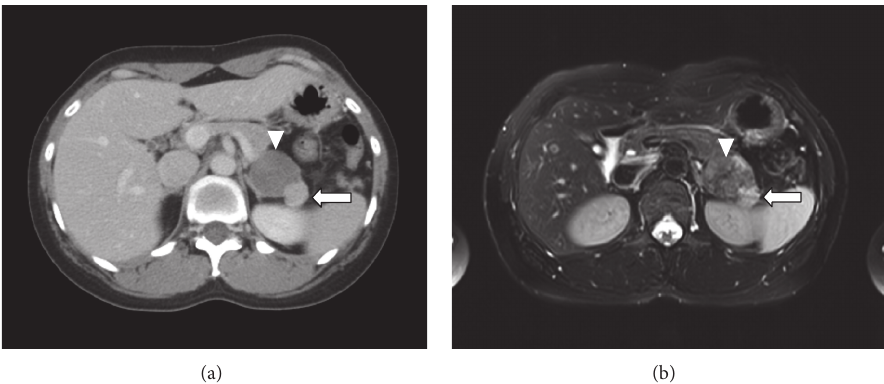
Figure 1: Imaging findings of the patient. (a) Computed tomography shows two adjacent round solid masses in the left suprarenal fossa: a 4cm low-density mass (arrowhead) and another 1.8cm enhancing mass (arrow). (b) On T2 magnetic resonance imaging, the 4 cm mass (arrowhead)showedintermediatesignalintensitywithsubtleperipheralanddelayedcentripetalenhancementinthearterialphase,suggesting a neurogenic tumor. In contrast, the 1.8cm mass (arrow) showed similar intensity to the spleen.